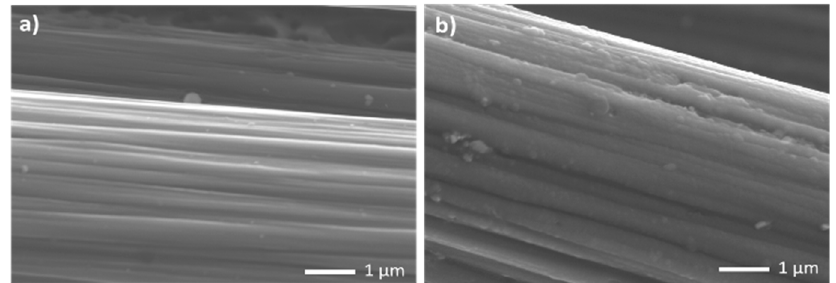
Figure 3. Scanning electron microscope images of ( a ) uncoated carbon fibre; ( b ) PPy.SDS coated carbon fibre .